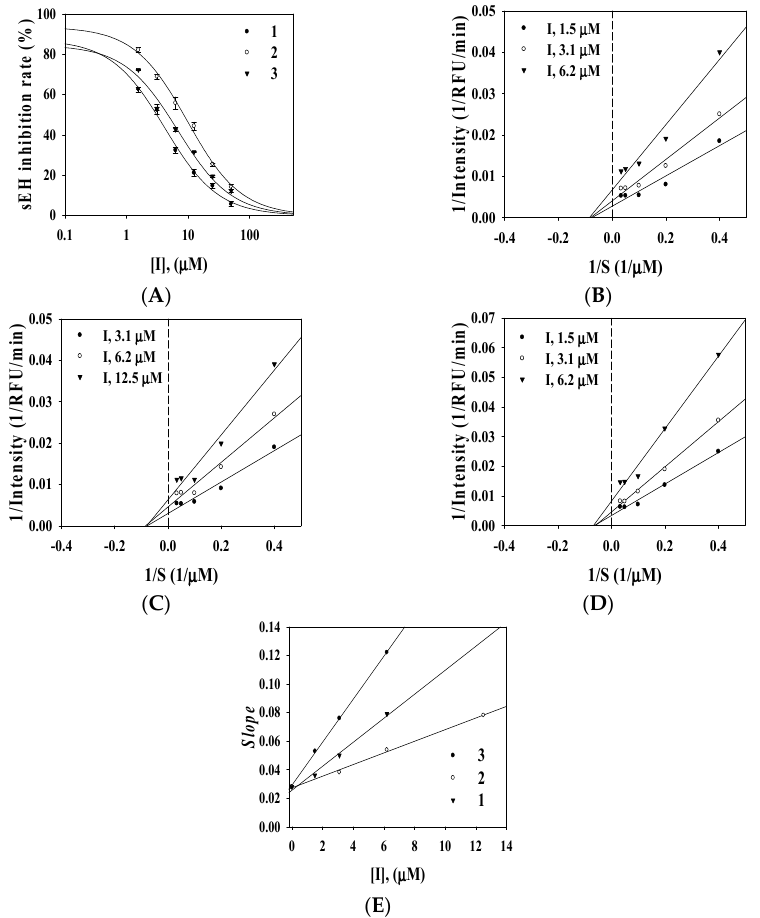
Figure 2. Effects of selaginellin derivatives 1 – 3 on the sEH activity ( A ); Lineweaver-Burk plots of sEH inhibition by 1 – 3 on the hydrolytic activity of sEH ( B – D ), and Secondary re-plot of Slope vs. [I] ( E ). Table 1. Inhibitory effects of selaginellin derivatives ( 1 – 3 ) on sEH activity.